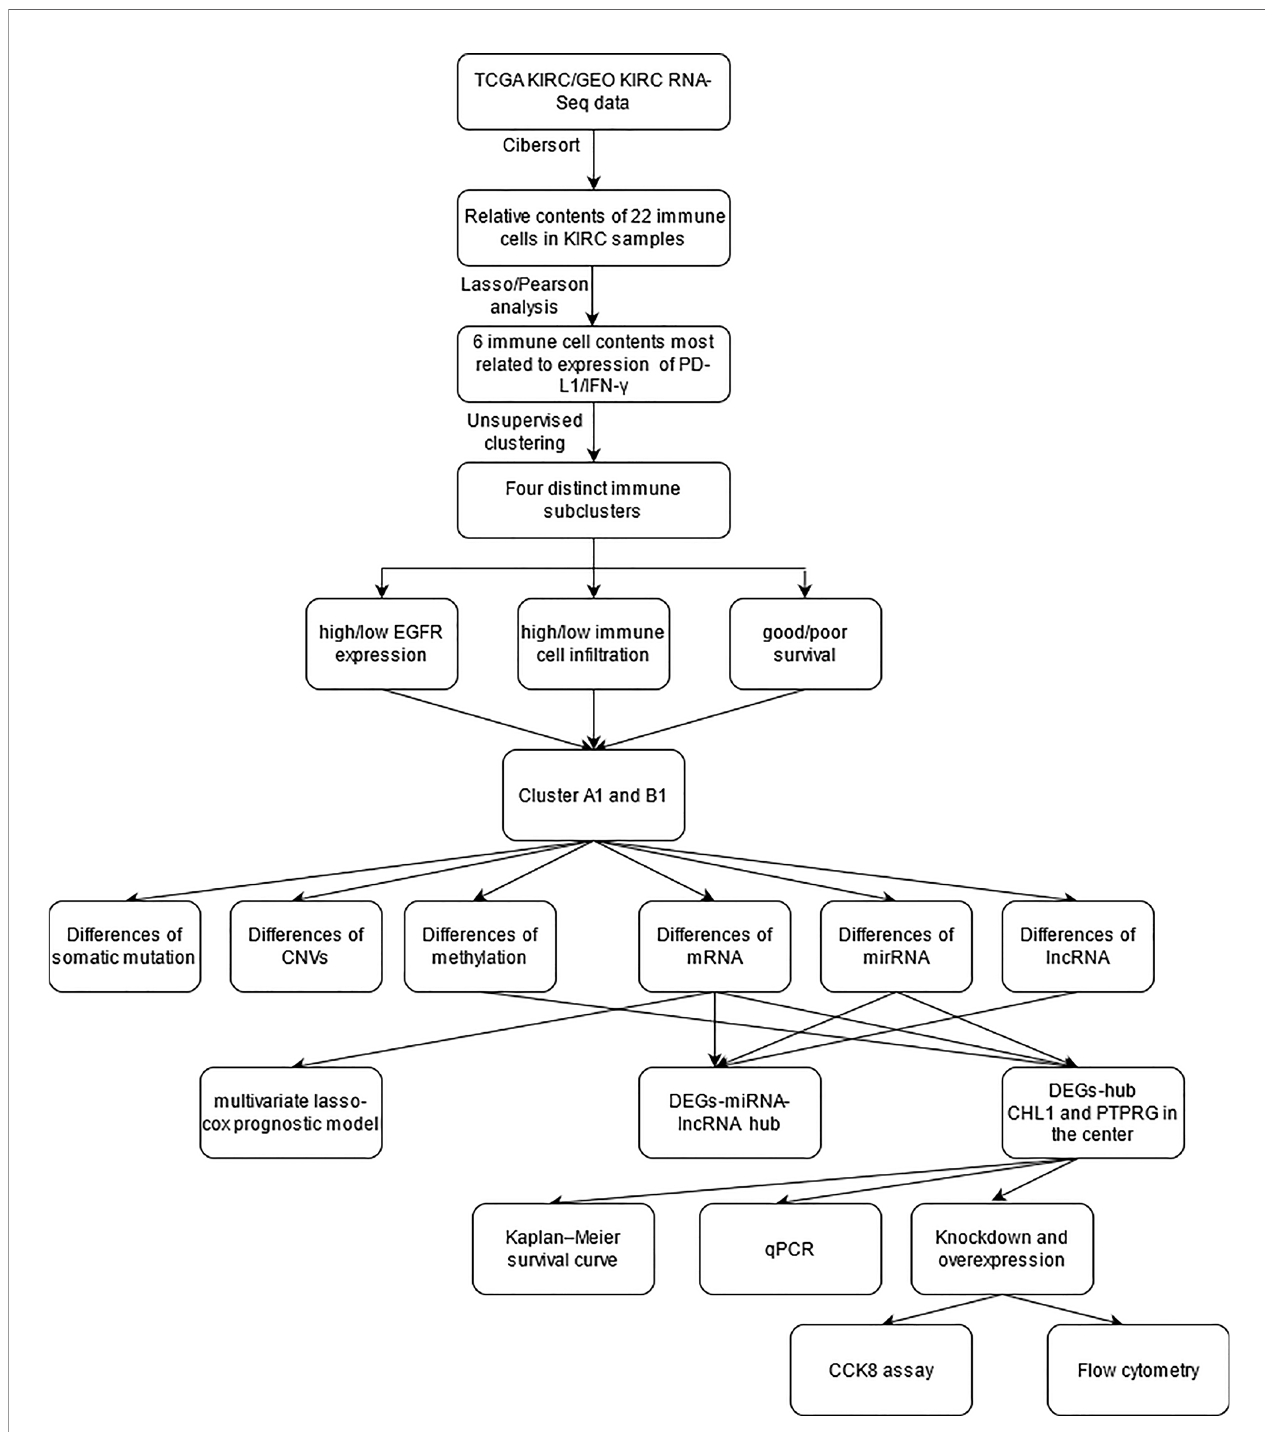
FIGURE 1 | The fl ow chart of the study